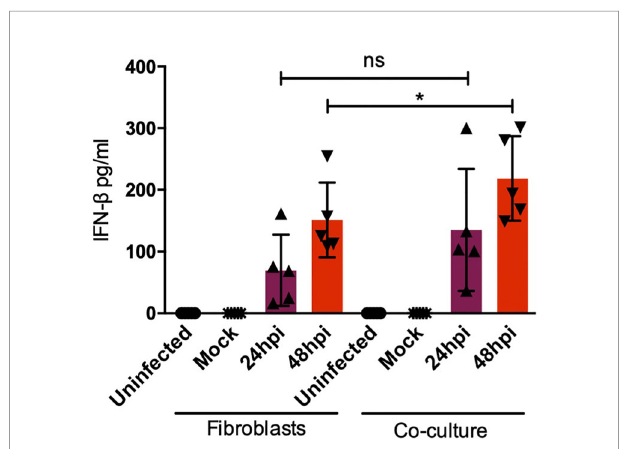
FIGURE 8 | nterferon b response in cocultures is enhanced by dendritic cells. Interferon b secretion in the monocultures and cocultures was assessed using ELISA at 24 and 48 hours after DENV-2 infection. Data are representative of at least three independent experiments for each donor; n = 3. * P <